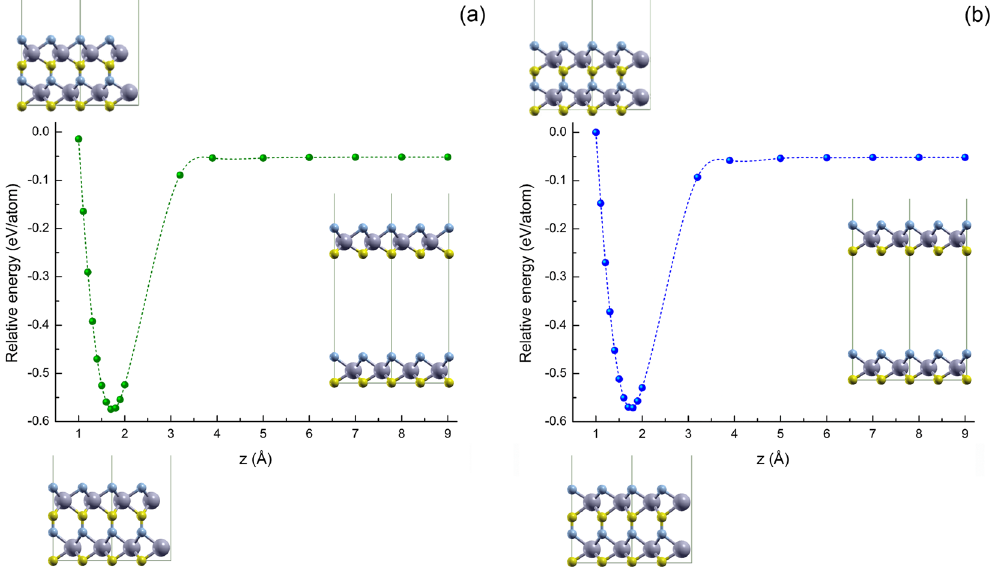
Figure 3. Interaction energy as function of the perpendicular distance between two ReCN monolayers. ( a ) Bulk-like stacking, and ( b ) on-top